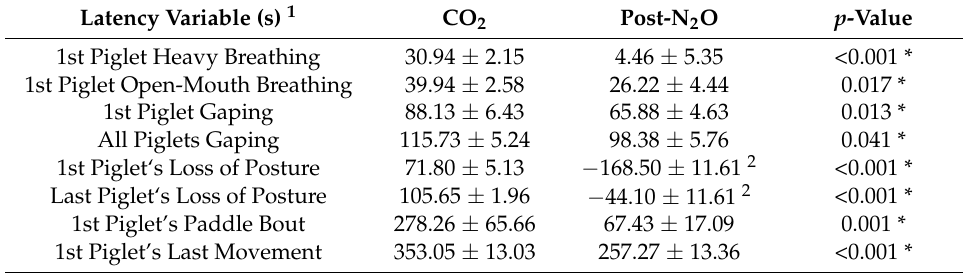
Table 8. Post-N 2 O vs. CO 2 treatment latency data (mean ± SE) on groups of piglets for Experiment